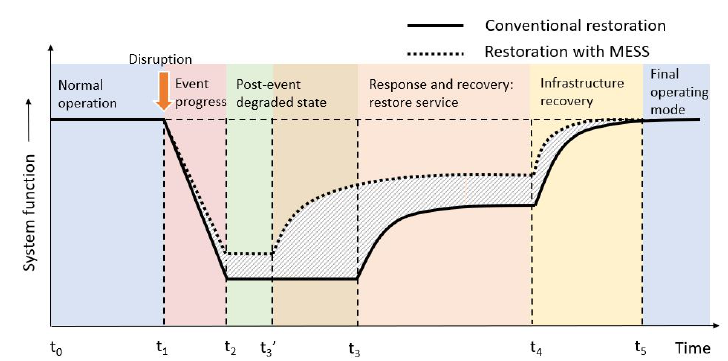
Figure 1. Conceptual comparison of distribution system restoration with and without MESSs follow- ing a disruptive event. Adapted from